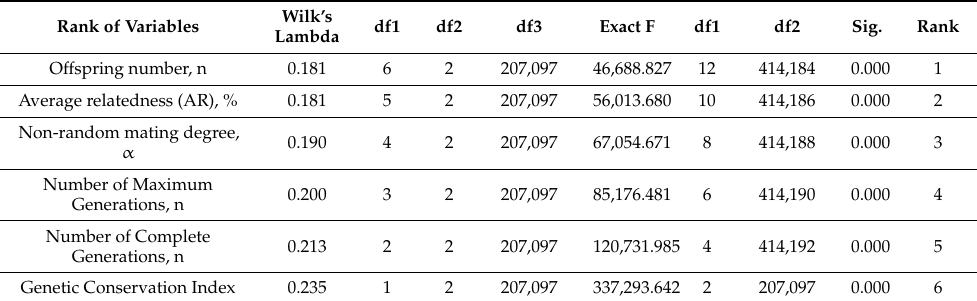
Table 10. Results for the tests of equality of group means to test for differences across breeds once redundant variables have been removed.